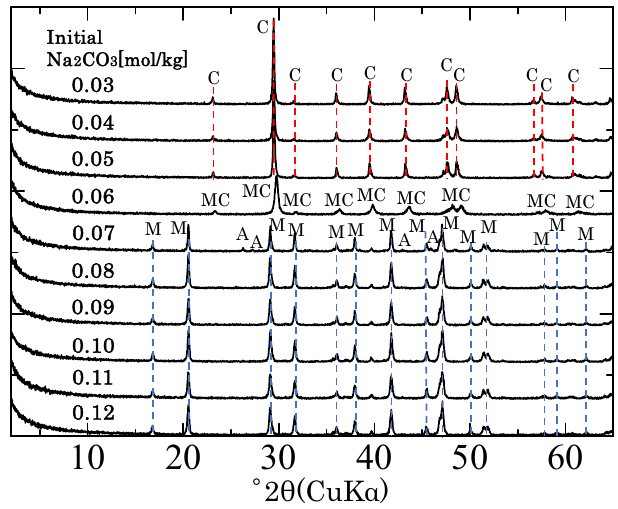
Figure 1. X-ray diffraction patterns of the solids obtained with different initial concentrations of Na 2 CO 3 . A: aragonite (CaCO 3 ), C: calcite (CaCO 3 ), MC: magnesian calcite ((Ca,Mg)CO 3 ), M: monohydrocalcite (CaCO 3 ·nH 2 O).